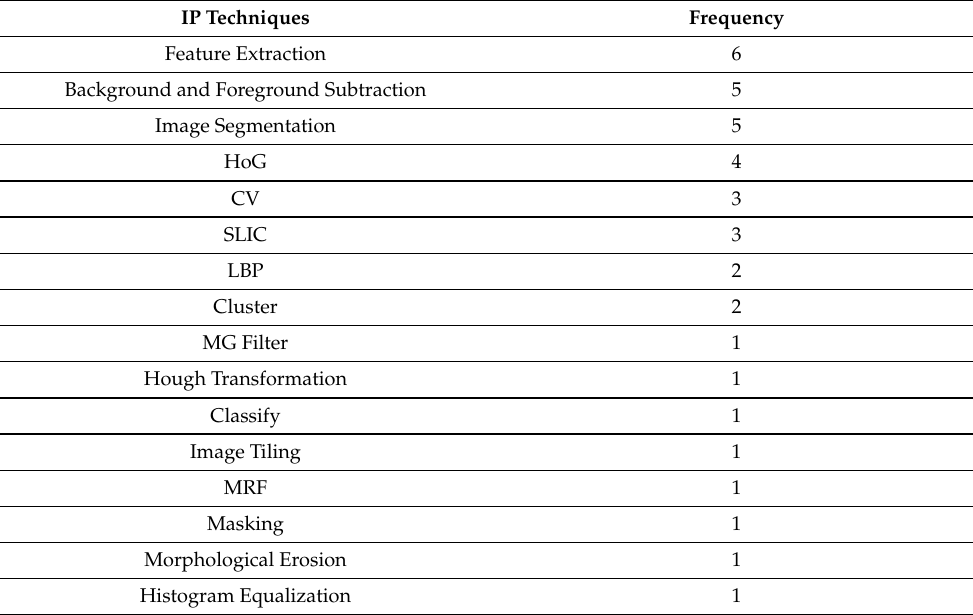
Table 6. Frequency Distribution of IP